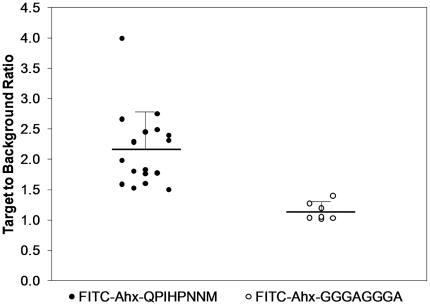
Quantitative analysis of peptide adsorption to distal colonic
adenomas showing target peptide FITC-Ahx-QPIHPNNM (2.17±0.61,
n = 18) binds greater to the adenomas when compared
to the control peptide FITC-Ahx-GGGAGGGA (1.14±0.15,
n = 7).The mean of each group is represented by a horizontal black line with one
standard deviation from the mean displayed. Non-parametric Mann-Whitney
independent samples analysis demonstrates target peptide binds more
significantly than control, p<0.01.